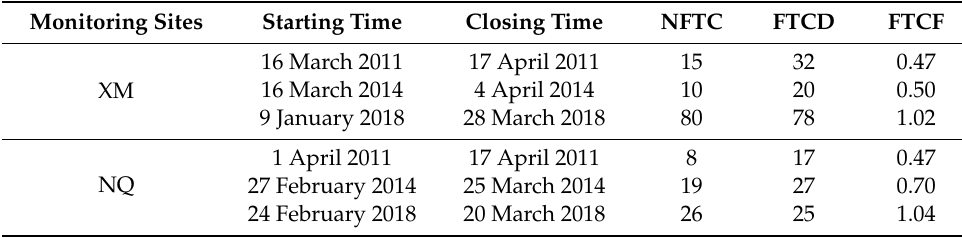
Table 3. The characteristics of the topsoil freezing-thawing cycles from January to June in Xiangmao Township (XM) and Nagqu Bridge (NQ) in 2011, 2014, and